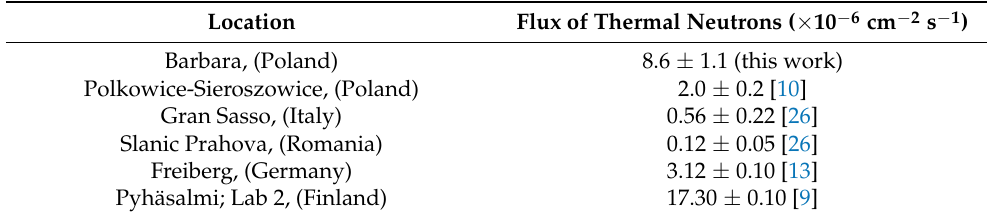
Table 2. Comparison of thermal neutron flux measurement in different European underground locations (complemented based on